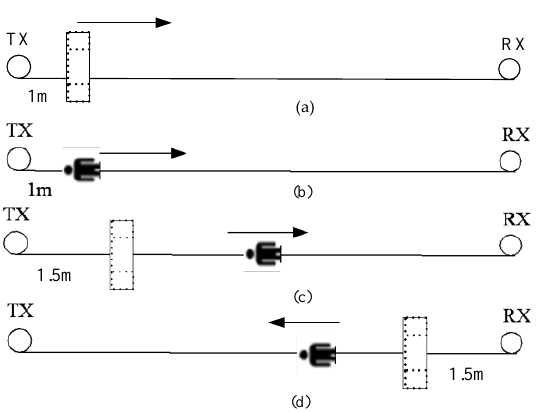
Figure 2. Cylinder and human body block models: ( a ) A cylinder moved along the TX-RX line; ( b ) A